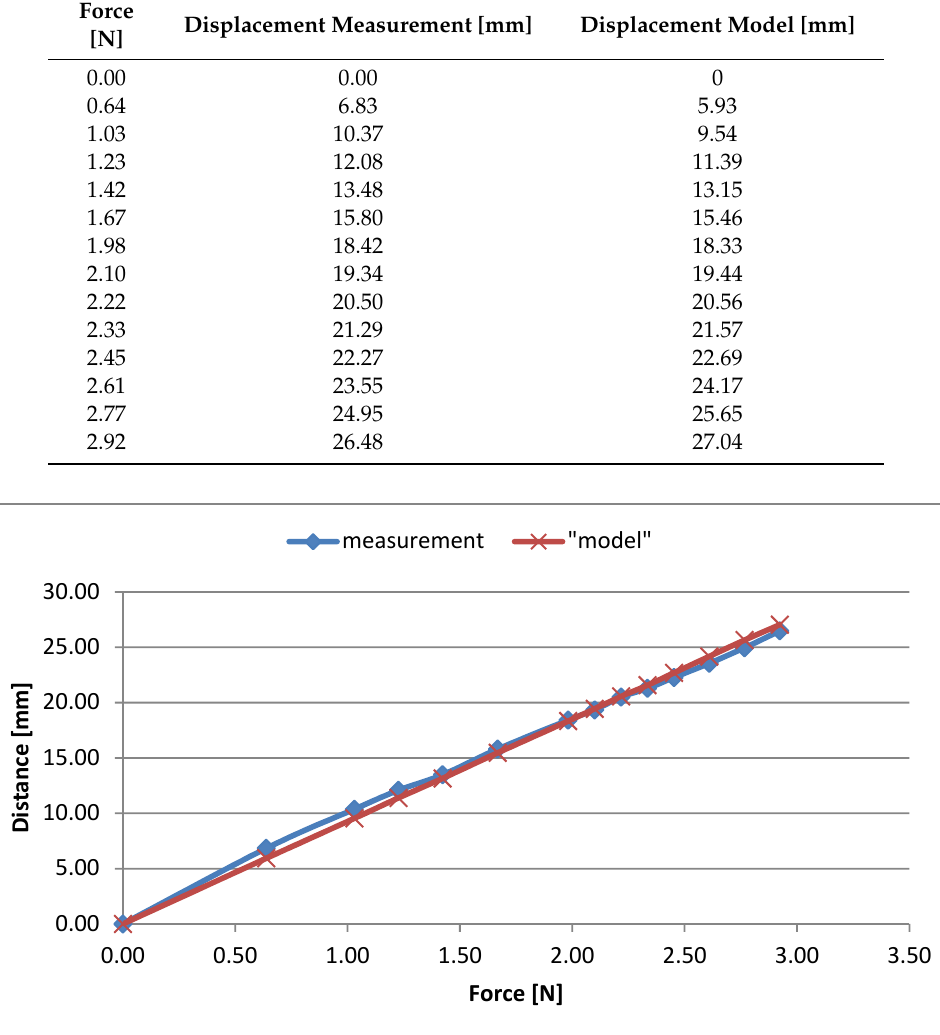
Figure 4. Comparison of membrane distances for different load forces.